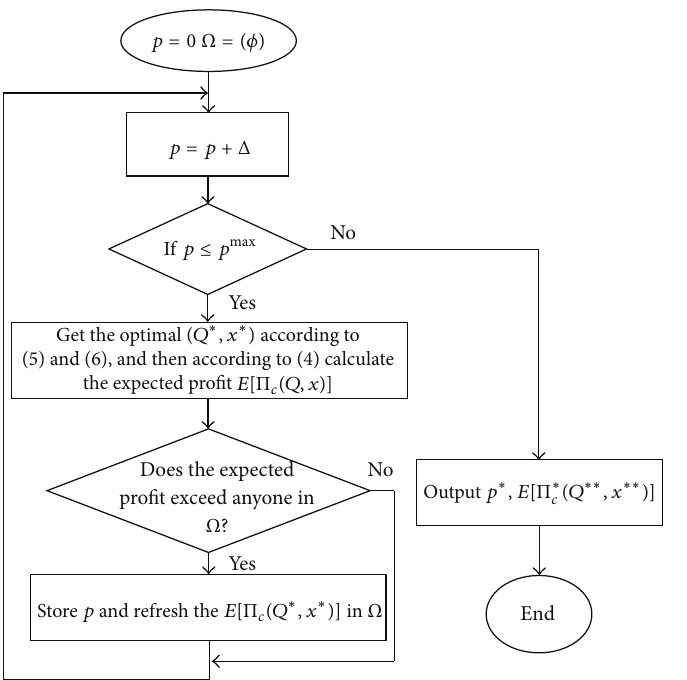
Figure 1: The algorithm process for dynamic pricing. 𝑝 max , maximized price for a kind of product; Δ , price markup coefficient; 𝐸[Π ∗ 𝑐 (𝑄, 𝑥)] , optimal expected profit of centralized system at the determined price 𝑝 ; 𝐸[Π ∗ 𝑐 (𝑄 ∗∗ ,𝑥 ∗∗ )] , optimal expected profit of centralized system at the determined price 𝑝 ∗ , while 𝑝 ∗ ∈ (0, 𝑝 max ]